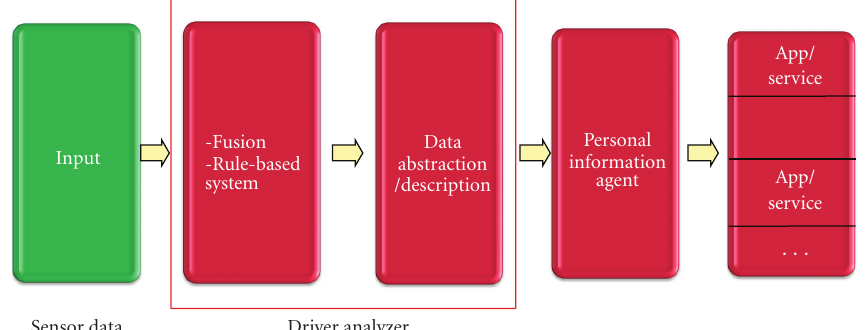
Figure 2: Abstract system description.